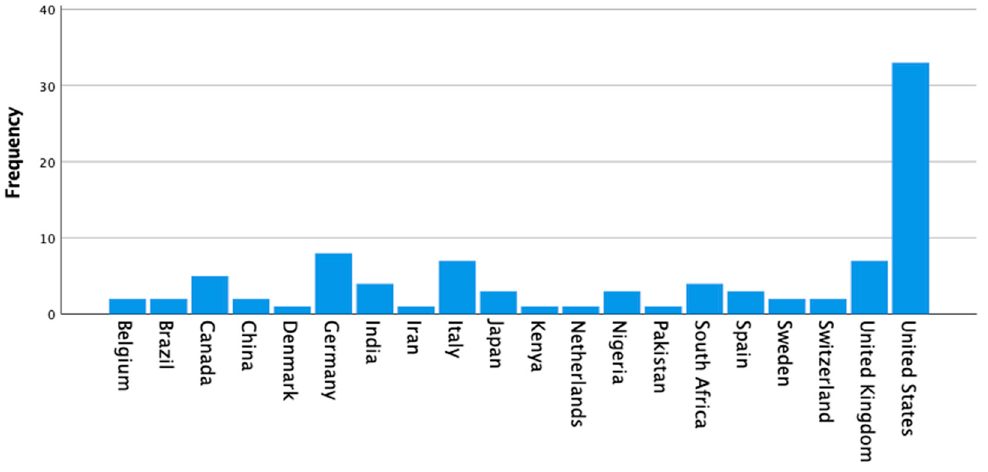
Figure 2. Frequency of documents per country of the bibliometric analysis with a range from one to 33 documents.